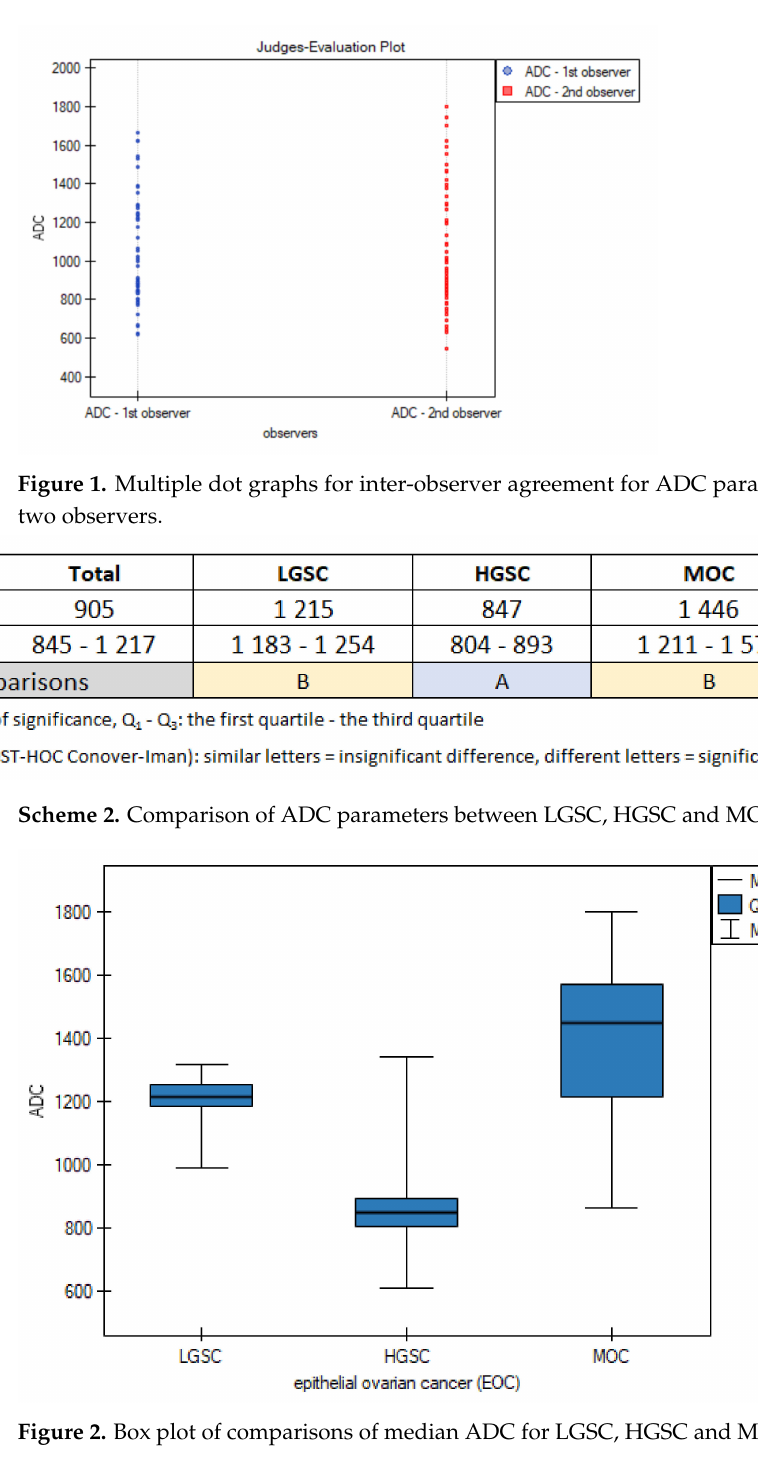
Figure 2. Box plot of comparisons of median ADC for LGSC, HGSC and MOC